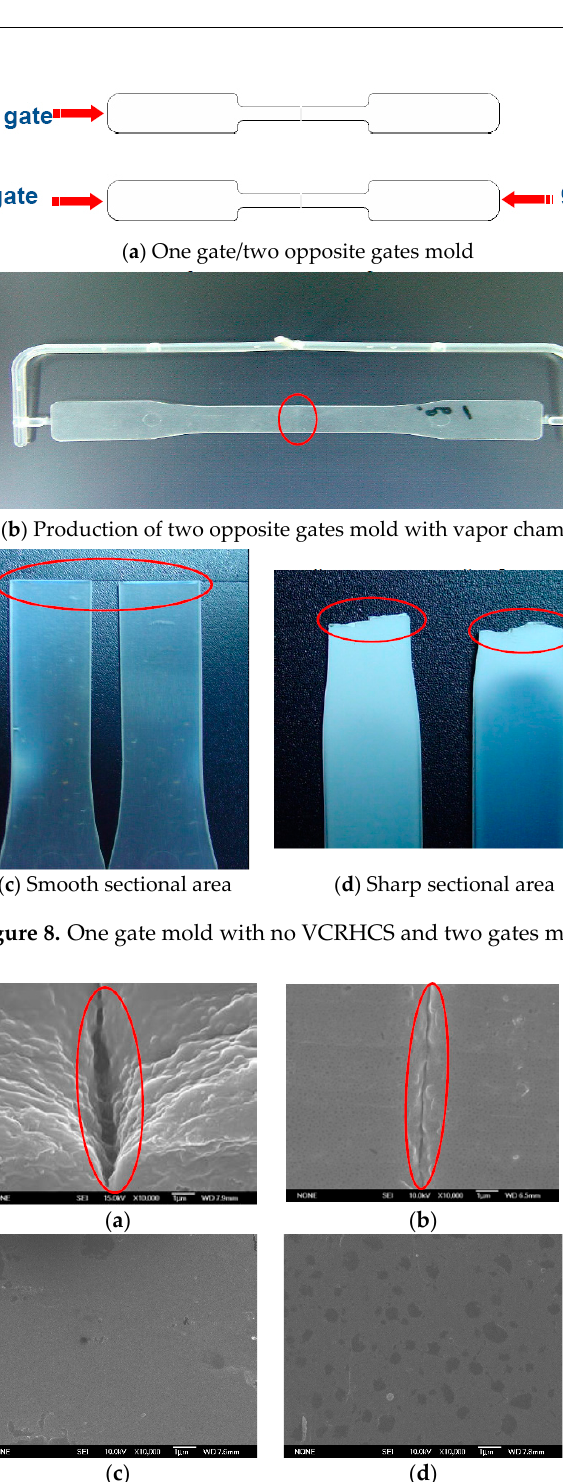
Figure 9. SEM photographs of one gate and two opposite gates. ( a ) Two opposite gates under Point O at 75 °C and with no VC apparatus. ( b ) Two opposite gates under Point O at 75 °C and with VC O at 75 ◦ C and with no VC apparatus. ( b ) Two opposite gates under Point O at 75 ◦ C and with VC apparatus. ( c ) Two opposite gates under Point O at 110 °C and with VC apparatus. ( d ) One gate apparatus. ( c ) Two opposite gates under Point O at 110 ◦ C and with VC apparatus. ( d ) One gate under Point O at 75 °C and with no VC apparatus. under Point O at 75 ◦ C and with no VC Table 1. The achievements of the tensile examination.